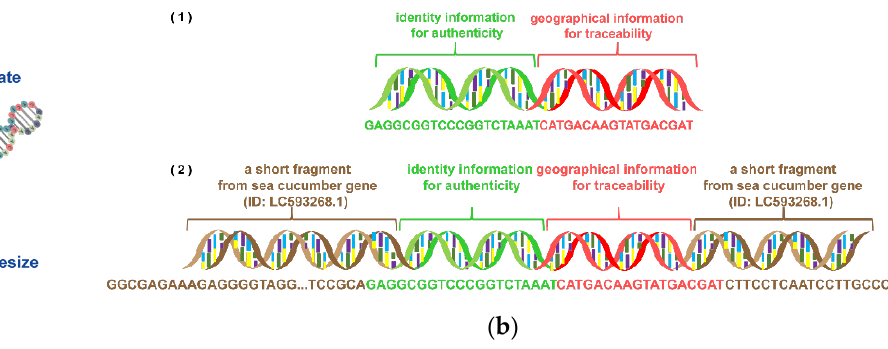
Figure 1. ( a ) Overview of storing and retrieving data into and from DNA-traceable barcode vectors; ( b ) DNA-traceable barcodes synthesis schemes. Fragment 1 was 38 bp in length, and fragment 2 was 112 bp.